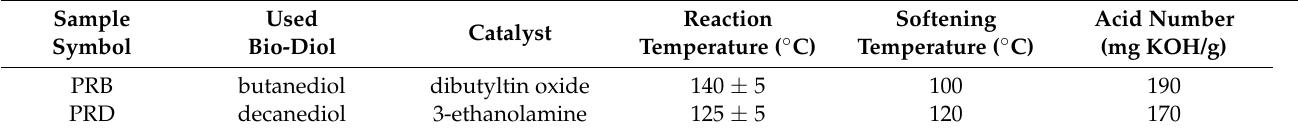
Table 1. Characteristics of rosin derivatives used in the formulation of coating compositions.